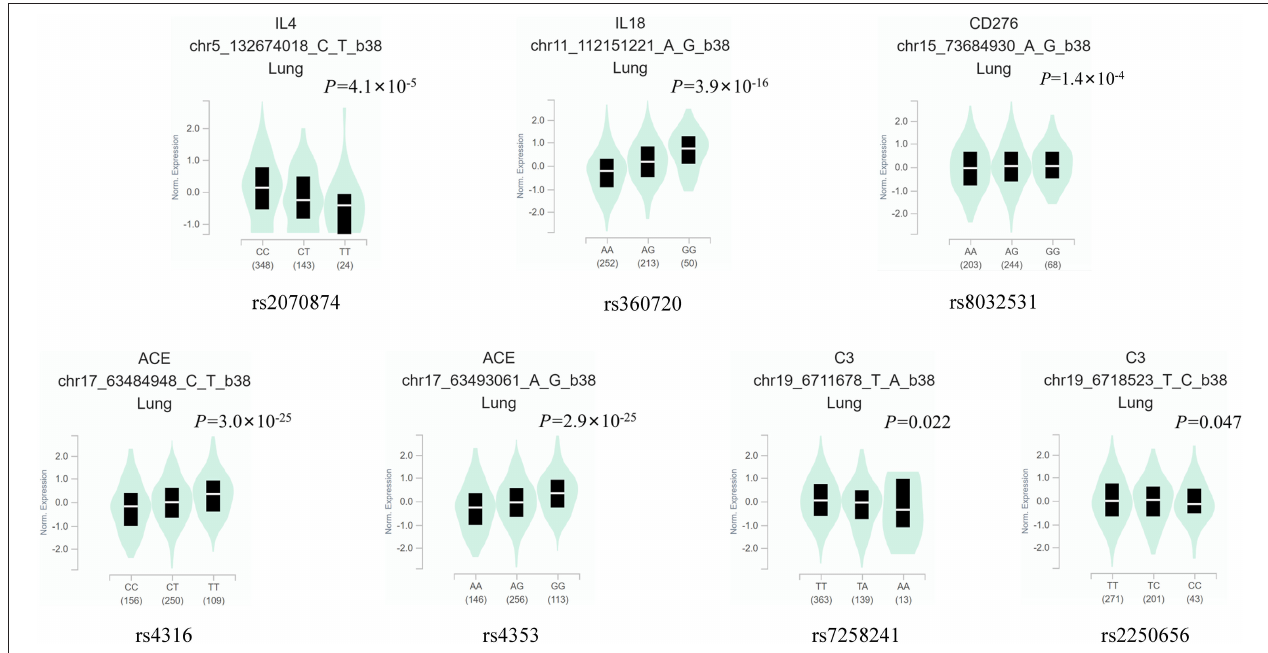
FIGURE 2 | The eQTL direction of the seven eQTL-SNPs in the GTEx database. eQTL, expression quantitative trait locus; SNP, single-nucleotide